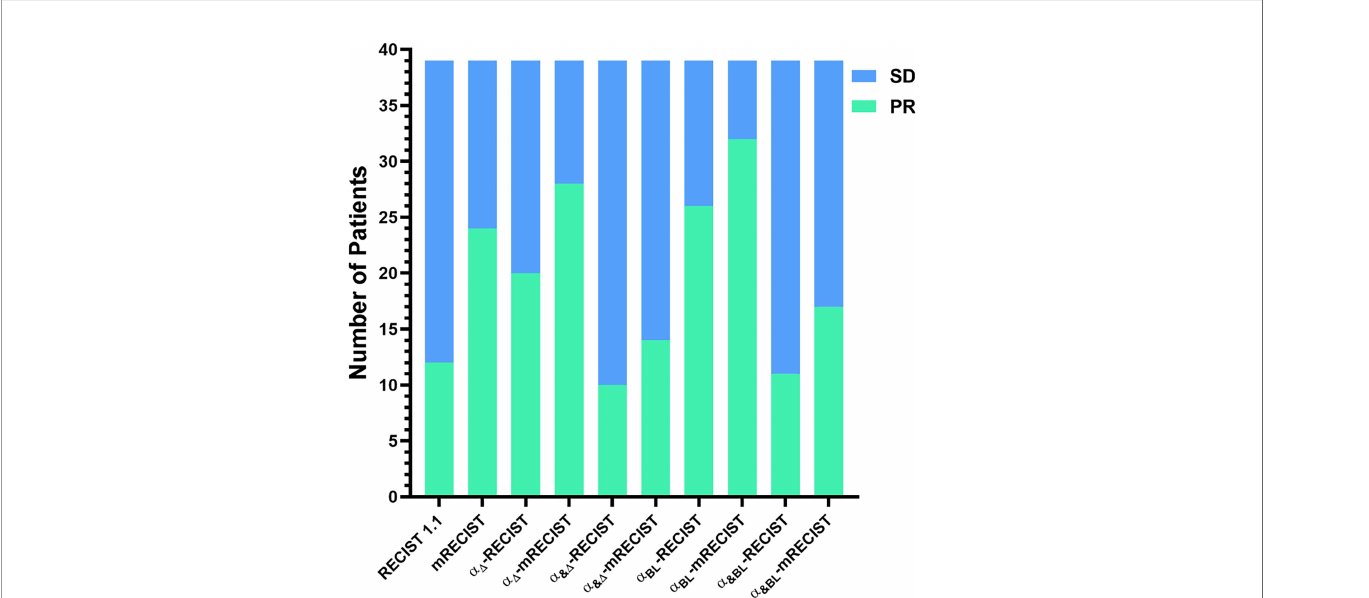
FIGURE 2 | Comparisons of evaluation categories among the different criteria.